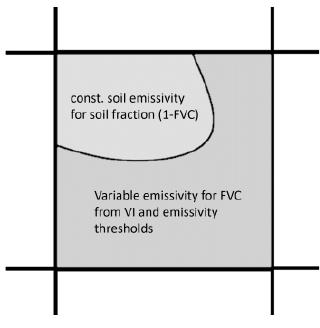
Figure 12. Pixel emissivity from